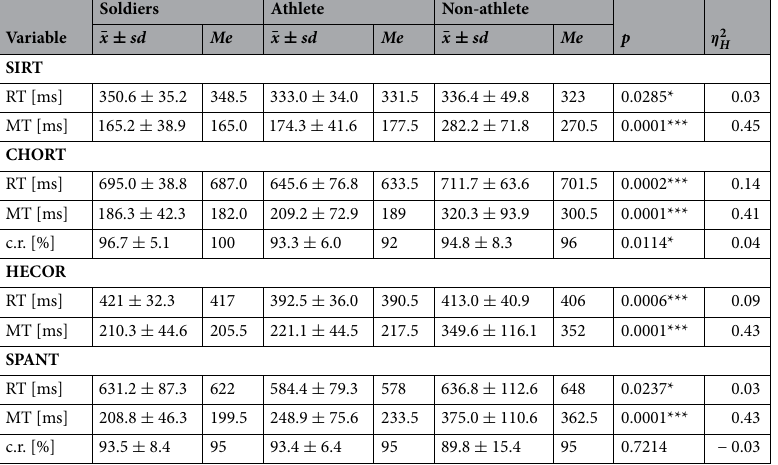
> 0.05, > 0.01, > 0.001 , η 2 H —effect size for the Kruskal– ∗ ∗∗ ∗ ∗ ∗